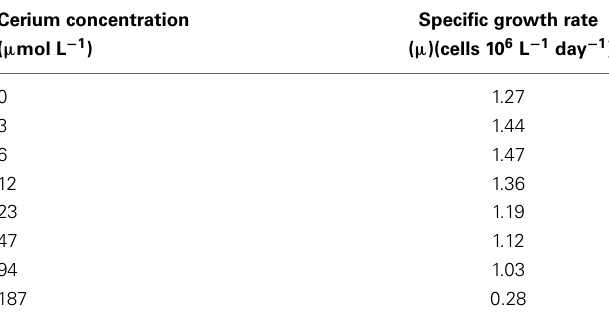
Table 4 | ICP-MS measurements of calcium and manganese in deficient media at 0 and 72h in the absence or presence of